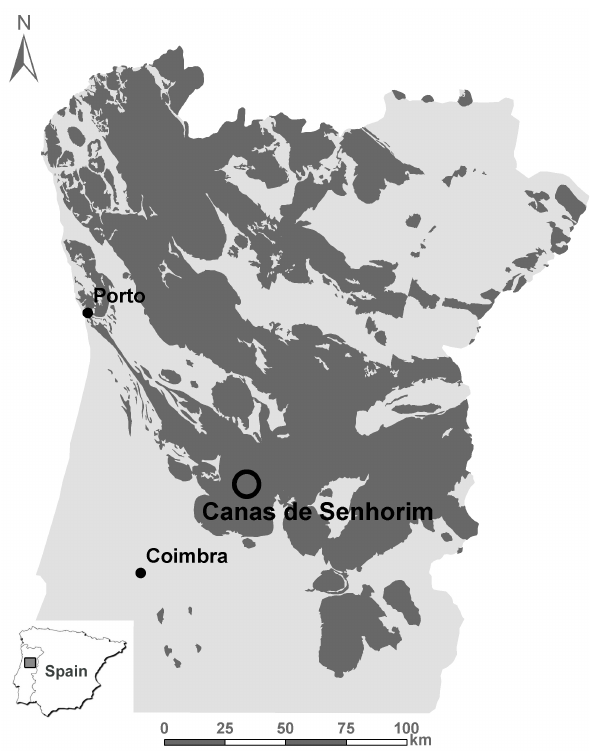
Fig. 1. Location of the Agrepor quarry, close to the town of Canas de Senhorim, Central Portugal. Hercynian granites are represented with grey colour.